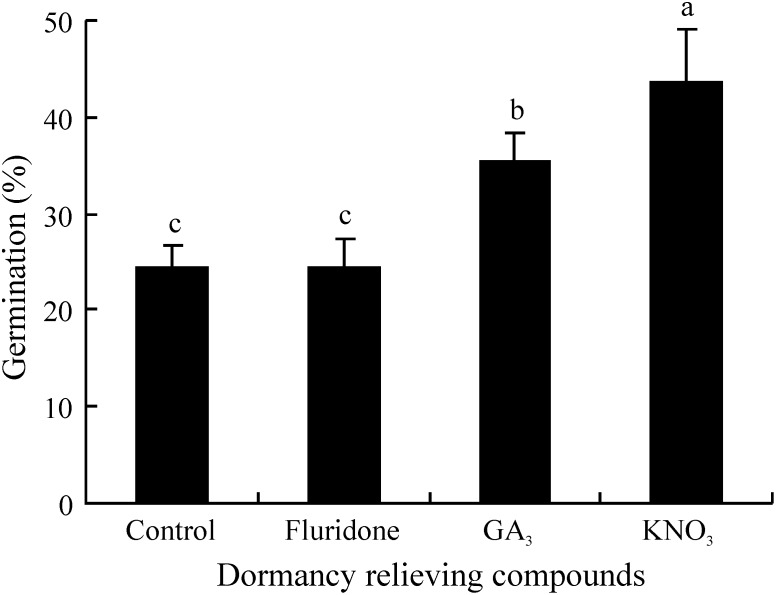
Effect of fluridone, GA3 and KNO3 on germination of fresh seeds of Stipa bungeana in dark at 20°C.Different letters indicate significant difference (P<0.05) among all treatments (n = 4).